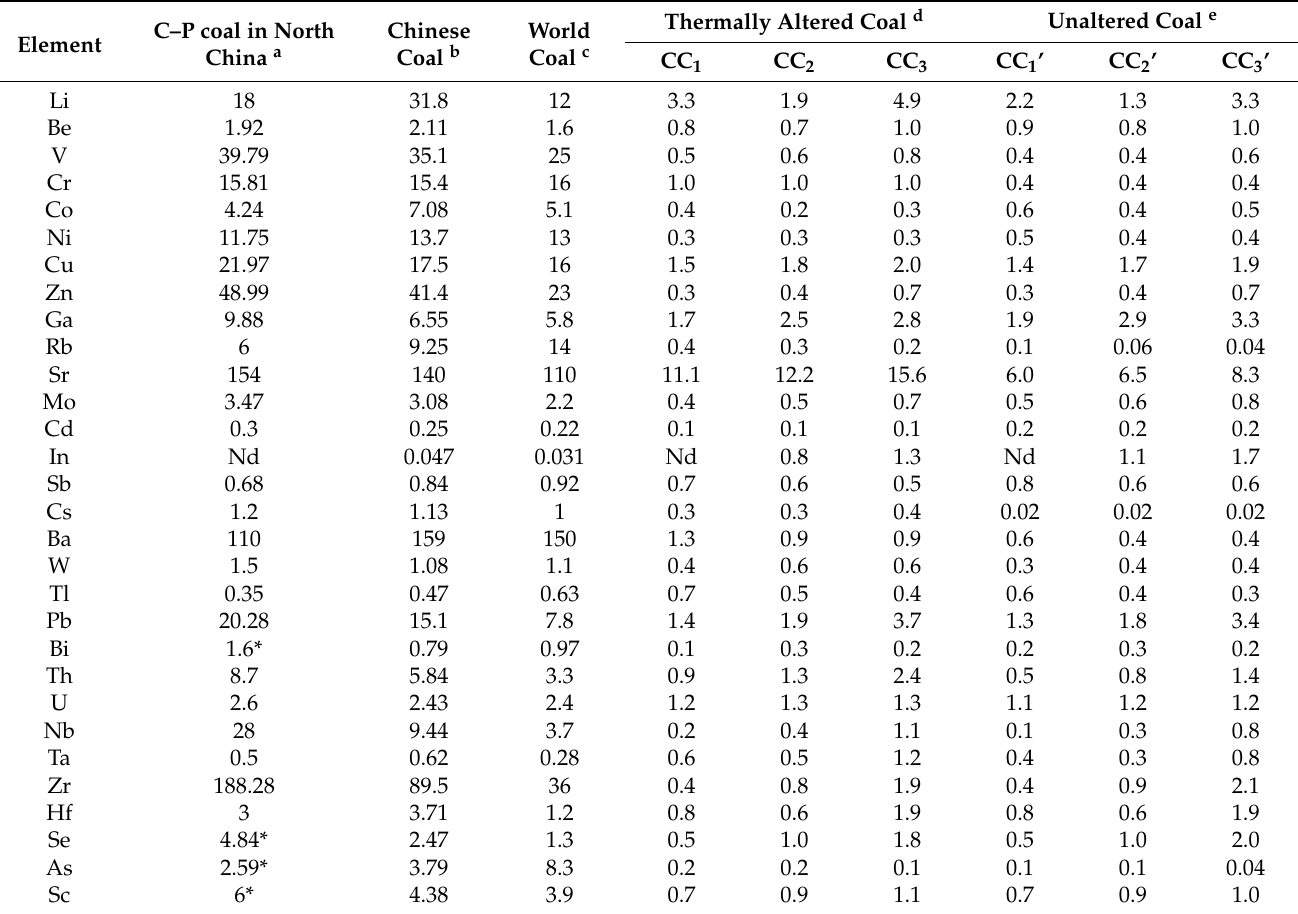
Table 8. Concentration coefficients of trace elements in the Tashan